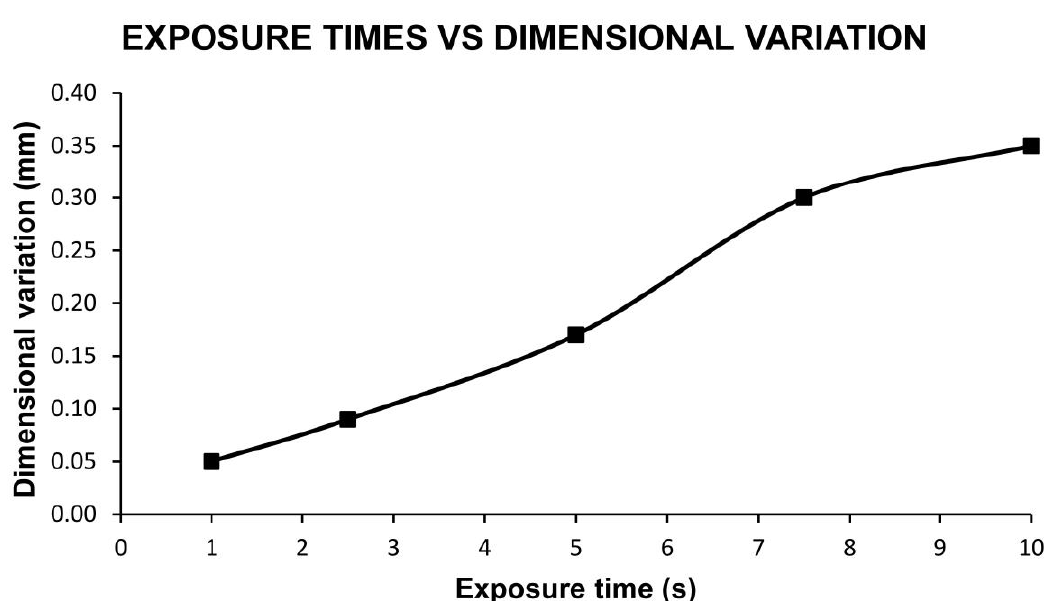
Figure 3. Dimensional variation for each exposure time and layer height of 0.30 mm.